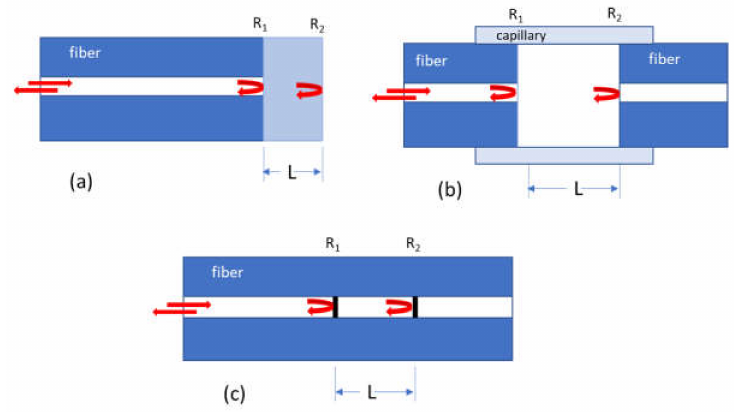
Figure 1. The different FOFPI types: ( a ) extrinsic type where the cavity is formed outside the fiber ( b ) extrinsic type where the cavity is formed between two fibers and ( c ) intrinsic type where the cavity is formed by two reflecting components along the